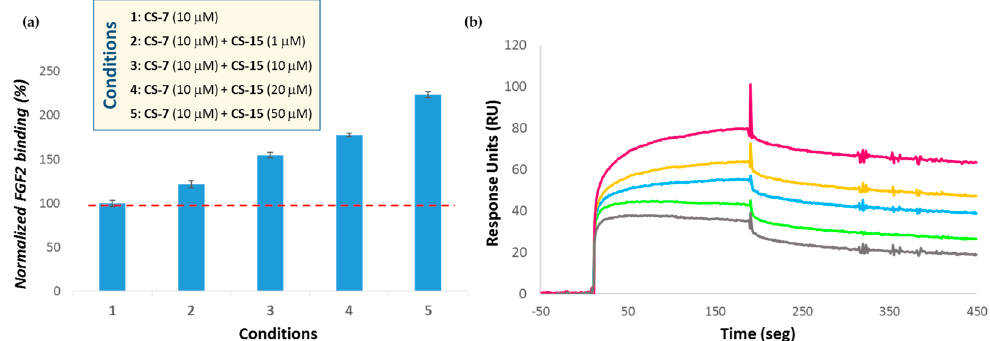
Figure 9. ( a ) Bar graph of normalized CS-7 binding preference to surface FGF-2 by competing with different concentrations of CS-15. The dashed red line indicates the lever of responsiveness of CS-7 alone. ( b ) SPR sensograms for binding-affinity measurements. The concentration of CS-7 was, in all cases, 10 µM, and concentrations of CS-15 were (from top to bottom): 50 µM, 20 µM, 10 µM and 0 µM.